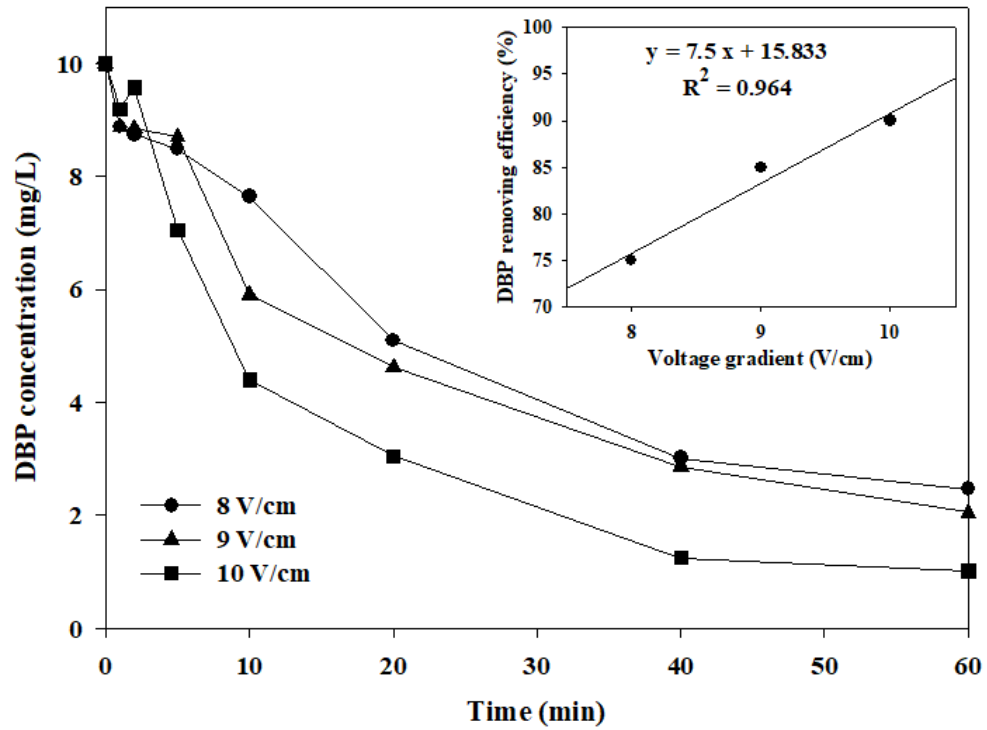
Figure 5. The variation of DBP concentration with different voltage gradients. Table 1. The comparison table for the DBP treatment with previous reports.